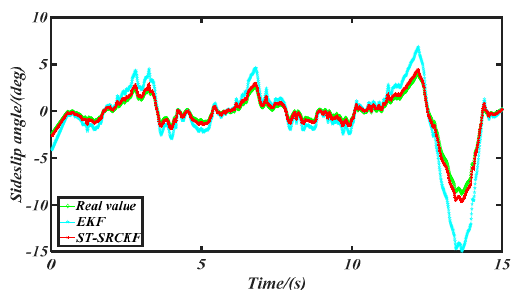
Figure 8. Vehicle speed.